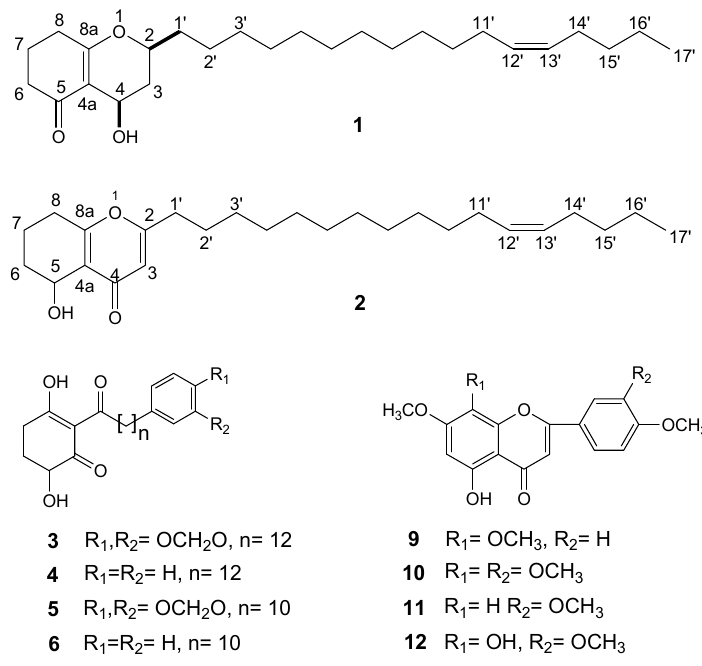
Figure 1. Structures of compounds 1 – 13